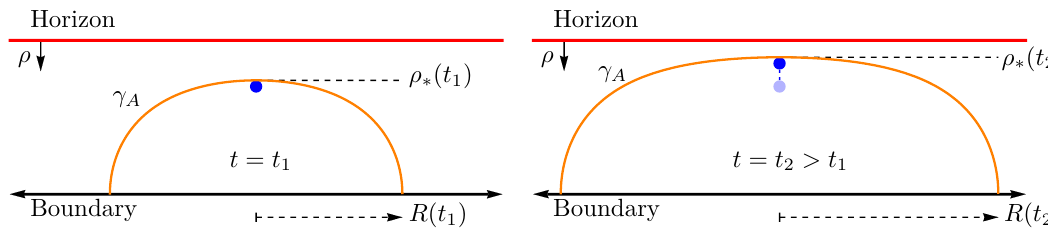
Figure 9 . Schematic diagram that illustrates the computation of the butterfly velocity V B using concepts of subregion-subregion duality [68]. The infalling particle (depicted in blue) represents a local perturbation that was created near the boundary at early times. The two figures shown correspond to snapshots of the configuration at late times t entanglement wedge that contains the particle at each time determines the function R ( t ) , which at late time can be shown to grow as R ( t ) ∼ V